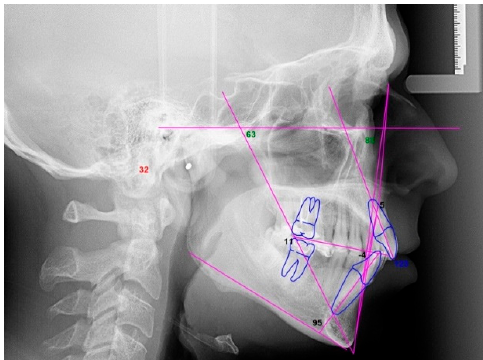
Figure 14. Case 2: cephalometric image.